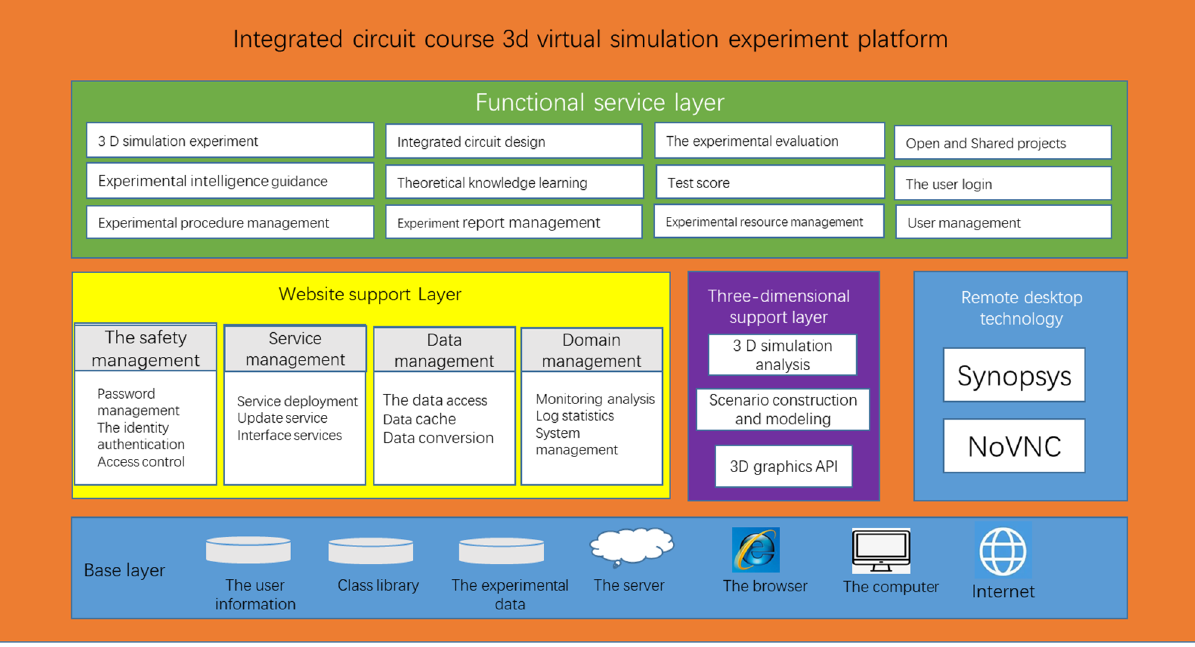
Figure 3. Project system architecture.